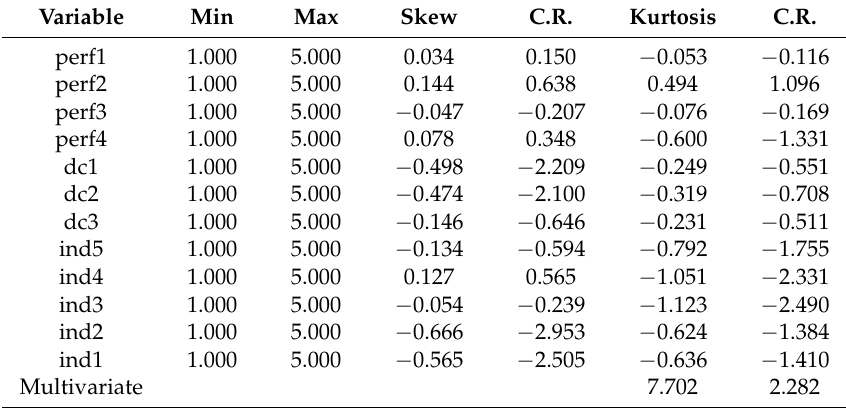
Table 2. Assessment of univariate and multivariate normality.